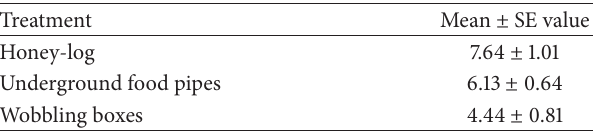
Table 3: Activity budget with enrichment